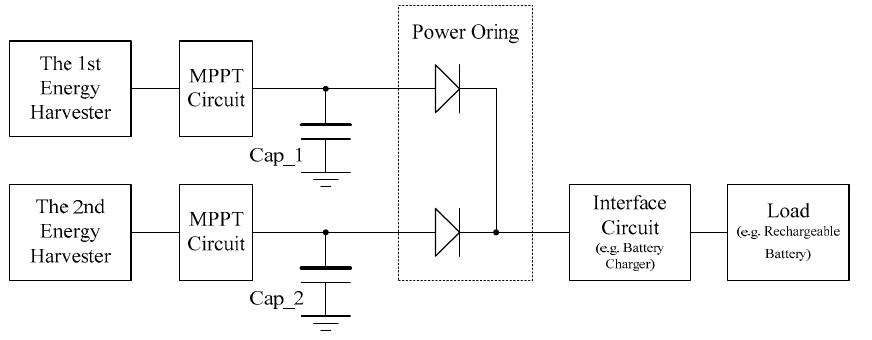
Figure 2. Conventional architecture of a multi-source energy harvester.